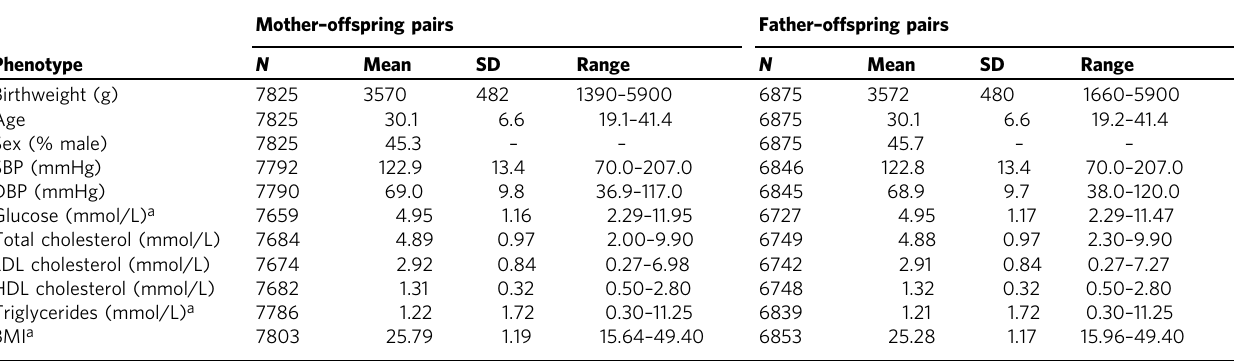
Table 1 Descriptive statistics for offspring cardiometabolic risk factors in the phenotypic association analyses. Mother – offspring